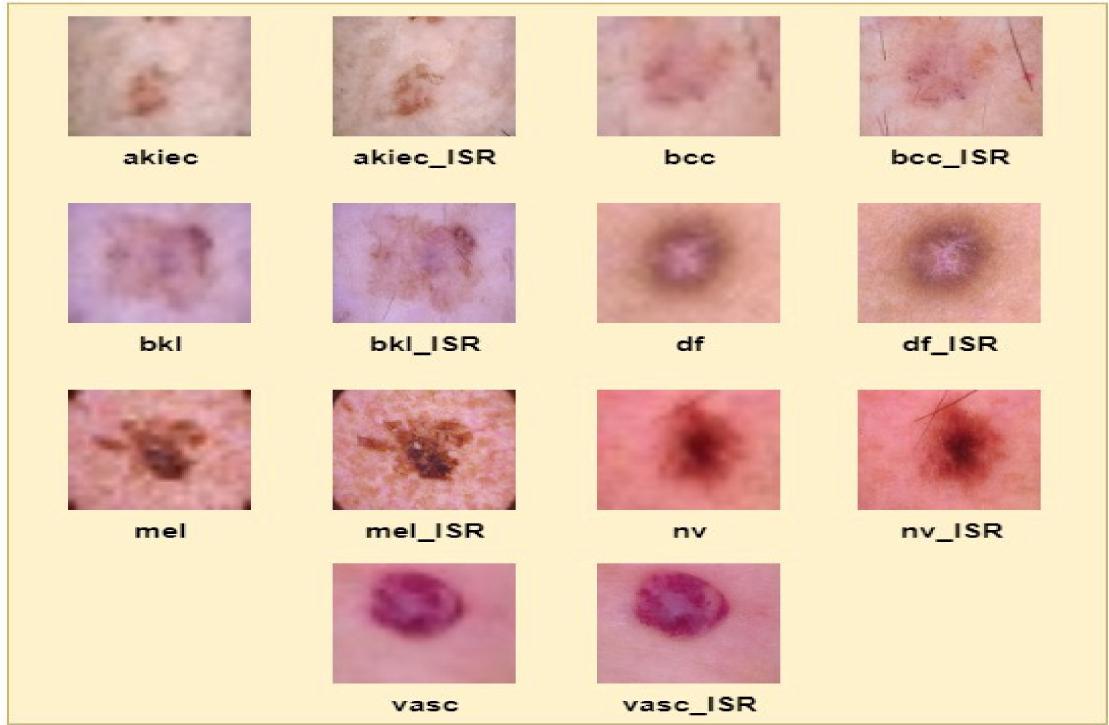
Figure 1. Comparison of sample images with their respective ESRGAN enhanced